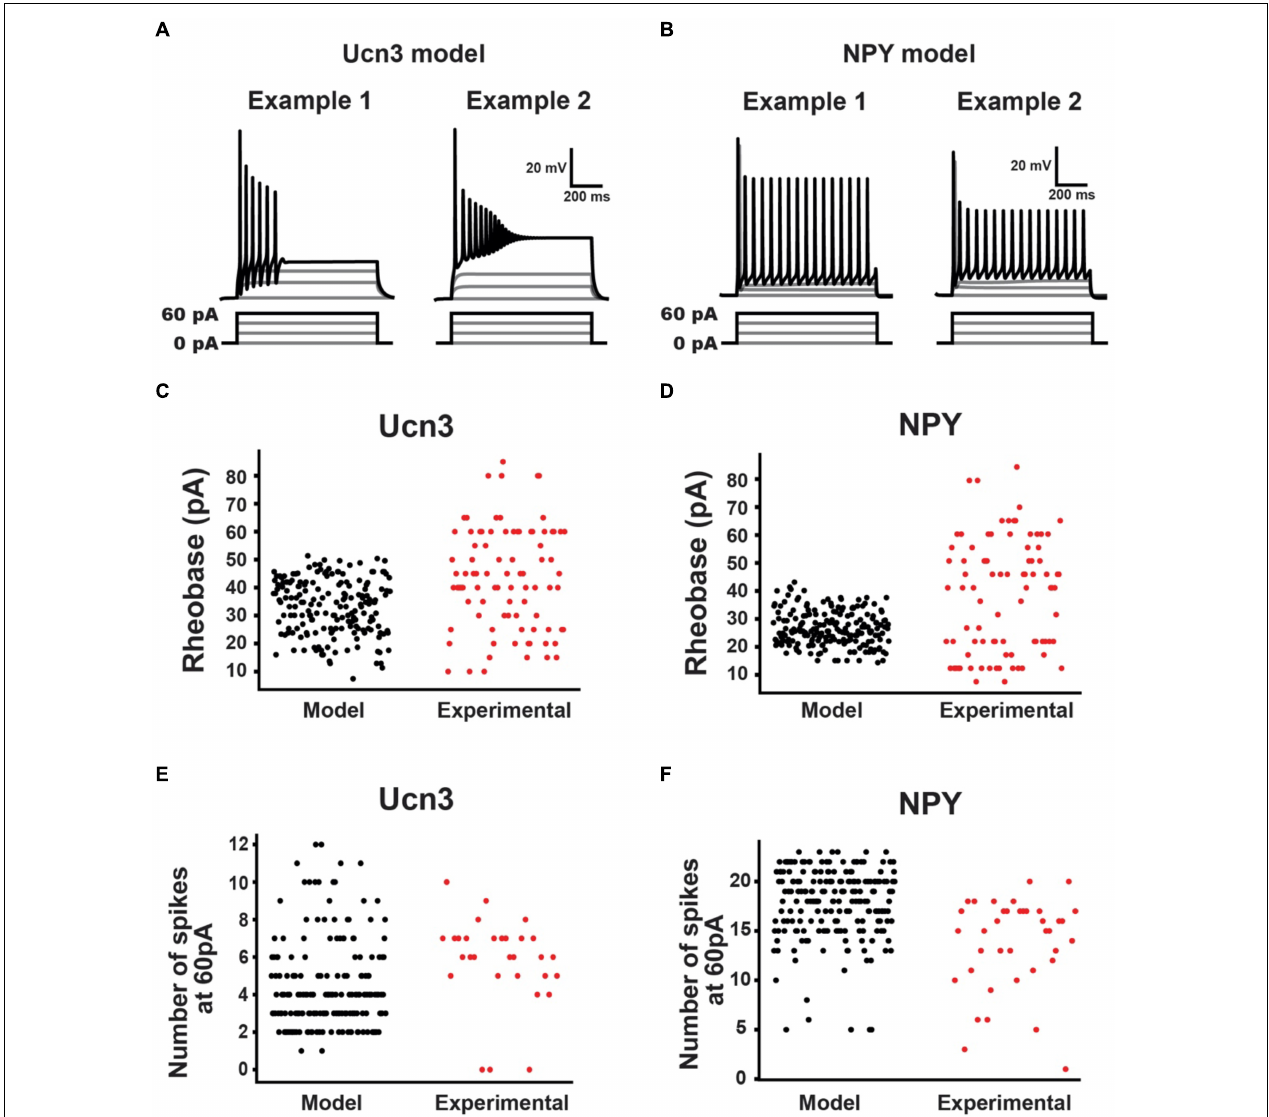
FIGURE 5 | Urocortin 3-positive (Ucn3 + ) and NPY + model neuron population characteristics. (A) Example Ucn3 + model neuron firing patterns during current injection. Ucn3 + model neurons demonstrated initial bursting patterns similar to our experimentally measured cells. (B) Example NPY + model neuron firing patterns during current injection. NPY + model neurons demonstrated tonic firing patterns similar to our experimentally measured cells. (C) Comparison of Ucn3 + model neuron rheobases (black) with experimentally measured Ucn3 + neuron rheobases (red). (D) Comparison of NPY + model neuron rheobases (black) with experimentally measured NPY + neuron rheobases (red). (E) Comparison of Ucn3 + model neuron number of spikes generated in response to 60 pA current injection (black) with those of experimentally measured Ucn3 + neurons (red). (F) Comparison of NPY + model neuron number of spikes generated in response to 60 pA current injection (black) with those of experimentally measured NPY + neurons